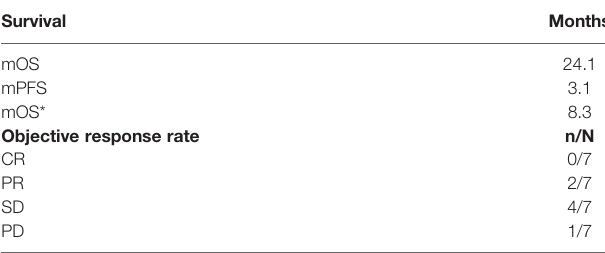
TABLE 3 | The survival and objective response rate of each patient.